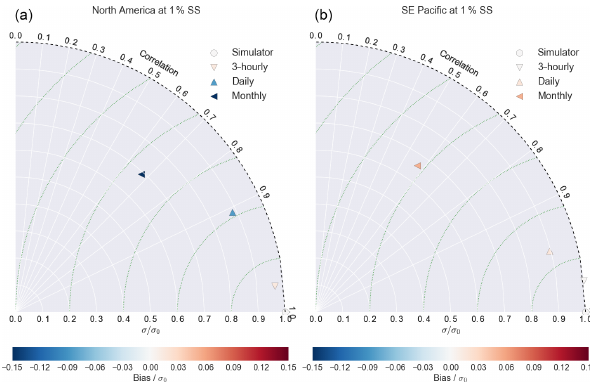
Figure 2. Taylor diagram showing the root mean square (rms) error and reduction in correlation and variability introduced by compar- ing instantaneous model output (using a flight track simulator) with interpolations from different temporal aggregations of the same model data. All datasets are linearly interpolated from the same un- derlying 4-D model field (CCN at 1% supersaturation) and com- pared with an online interpolation. Panel (a) shows points taken over North America; panel (b) shows points over the south-east Pa-